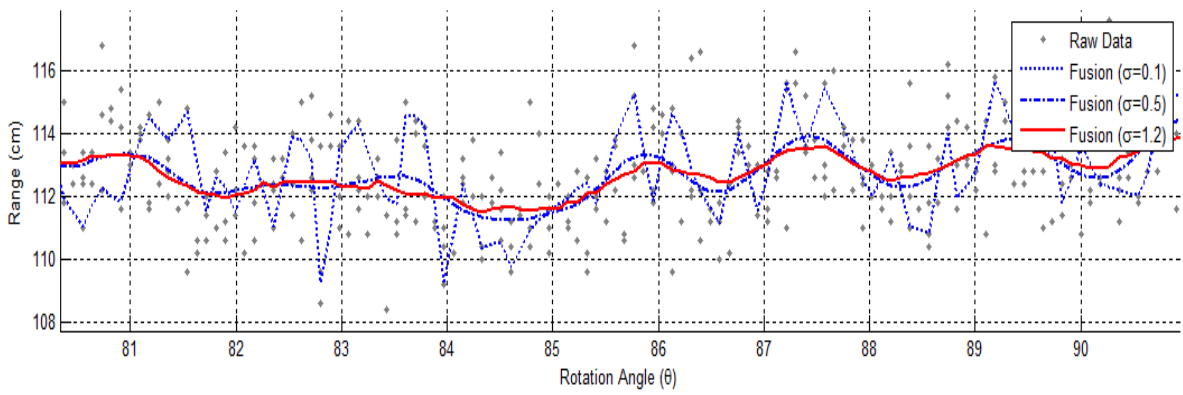
Figure 4. Kernel-based Range Data Fusion with Various 